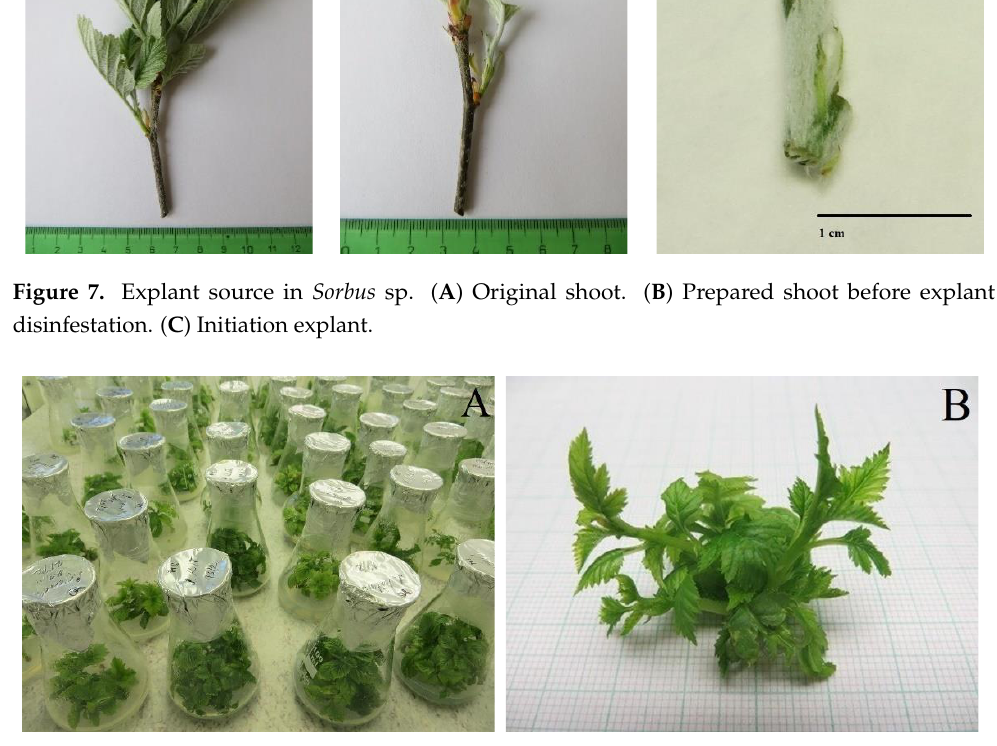
Figure 8. Bulking of stock material in Sorbus species on full-strength solid Murashige and Skoog (MS) basal medium with vitamins supplemented with 0.5 mg·L – 1 N 6 -benzyladenine (BA) and 0.1 mg·L – 1 indole-3-butyric acid (IBA). ( A ) In vitro collection of Sorbus species. ( B ) Detail of shoot regeneration in Sorbus × abscondita .